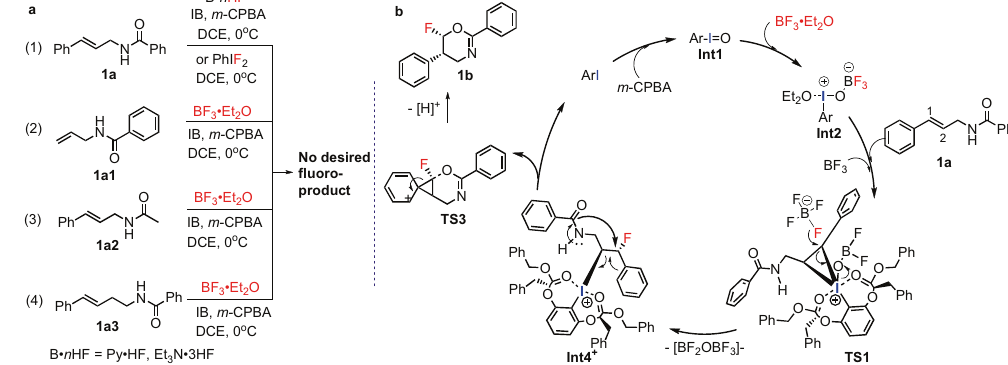
Fig. 5 Plausible mechanism of the catalytic asymmetric nucleophilic fl uorinations. a Control experiments. b Plausible catalytic intramolecular n − σ * interactions between the electron-de fi cient iodine (III) center and the carbonyl groups 50,51 . For the impacts of steric hindrance, the nucleophilic attack of F − on the Si face was favored (Fig. 5b), and this is in consistence with the experimental results and DFT calculations (Fig. 6b). As seen from the energy pro fi le, the enantioselectivity is determined by the addition of F - with [BF 4 ] - as fl uorine source to the cationic Int3 + (Fig. 6a). The energy of TS1 versus ent - TS1 , the transition state to the minor product, is compared. Surprisingly the two TS s exhibit huge energy difference of 14.9 kcal/mol (Fig. 6b). A closer observation on the geometry shows that ent - TS1 is much later, and bears a signi fi cantly longer I-O distance. In both TS s, the hypervalent I(III) atom is stabilized by interaction with the amide oxygen atom in the alkene. It could be proposed that the relative direction of alkene and catalyst in ent - TS1 disabled the feasible I- O interaction that provides essential stabilization to the iodane, leading to both a later transition state and much higher energy. The formation of Int4 is achieved through the interaction between TS1 and BF 3 , and Int4 is found to be 23.7 kcal/mol lower in energy than TS1 . Then Int4 releases anionic [BF 2 OBF 3 ] − to form Int4 + , and Int4 + is found to be 5.5 kcal/mol lower in energy than Int4 . Dearomatization of Ar 1 ring of Int4 + by intramolecularly nucleophilic attack of the Ar 1 on Si face at C2 position (Fig. 5b) furnish the cyclopropyl compound TS2